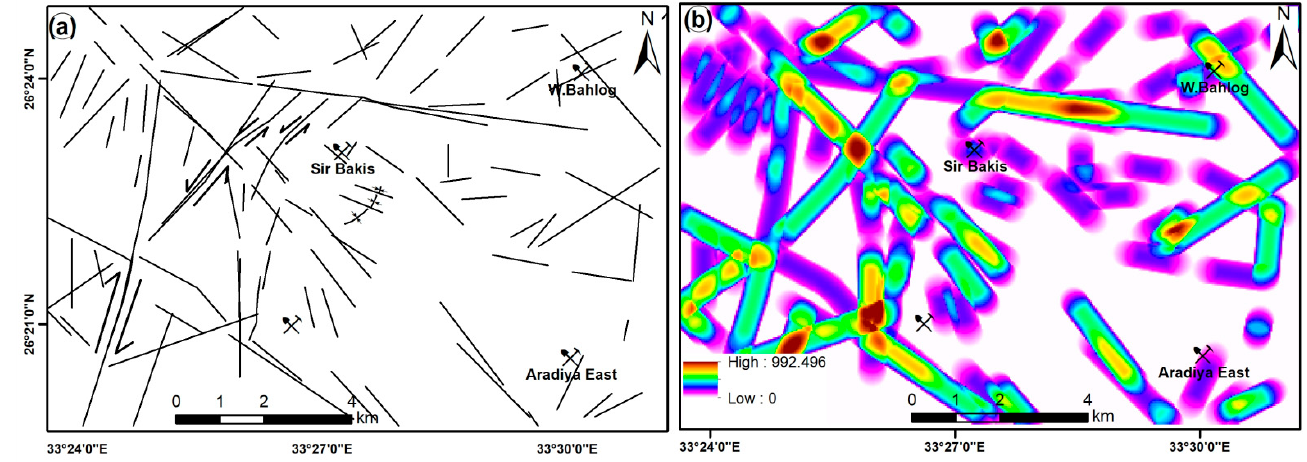
Figure 8. ( a ) Lineaments derived from remote sensing data; ( b ) lineament density